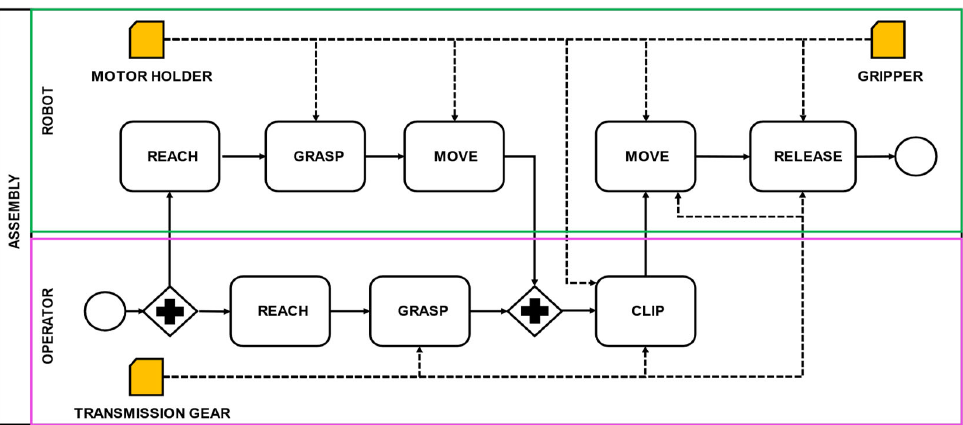
Figure 5. Example of modeling for a collaborative assembly task. One pool named “assembly” is used to contain all the steps concerning the process. Afterwards, two lanes, “ROBOT” (in green) and “operator” (in pink), are used to depict the actions that each actor should perform for the collaborative task. Finally, passive resources complementary to the actions (in orange) are connected to the different actions. This representation allows one to identify all resources (robot, operator, transmission gear, gripper, and motor holder) involved in a unique process (assembly). Moreover, the unfolding of the different actions is clearly assigned to each actor (e.g., the operator needs to perform reach, grasp, and clip).